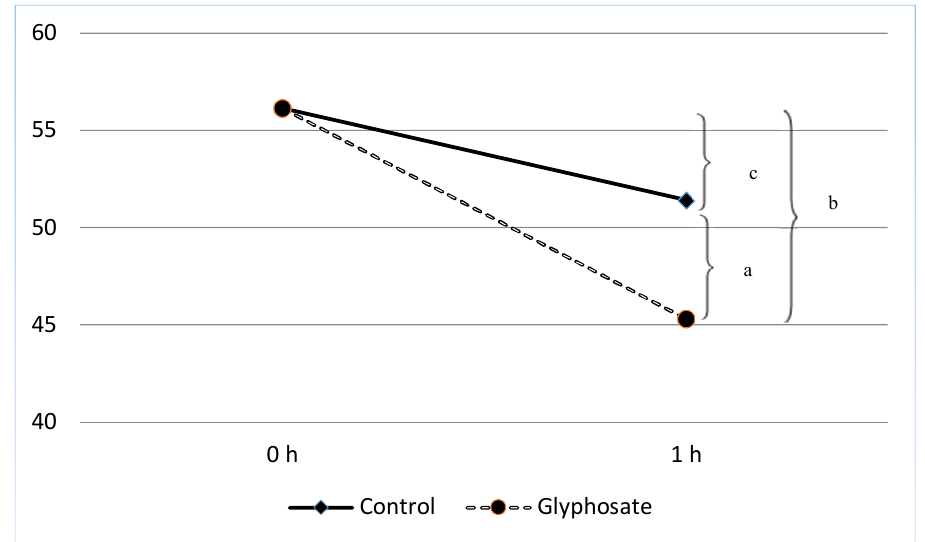
Figure 1. Percentage of progressive motility (PRM) between glyphosate-treated ( n = 30) and control sperm samples ( n = 30). Progressive motility of glyphosate-treated sperm samples was significantly lower compared to control samples (51.4% ± 2.4% vs. 45.3% ± 2.6%, a < 0.05) 1 h post-treatment. The reduction (5.3%) between zero time and 1 h post-treatment in the control samples was not significant (c > 0.05), while the reduction (11.4%) between zero time and 1 h post-treatment in glyphosate-treated samples was significant (b < 0.05). Table 1. Demographic data of all men studied and basic sperm parameters at zero (0) time.